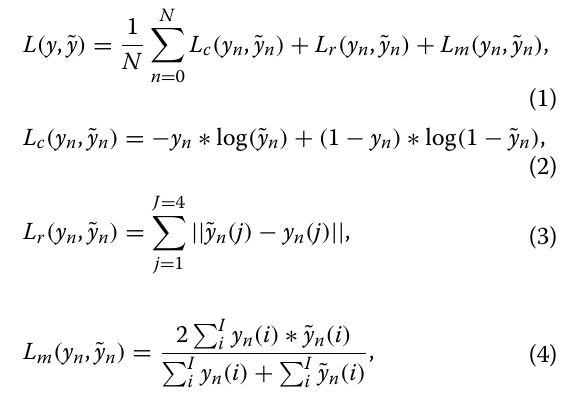
The mask regional convolutional neural network (Mask R-CNN) runs over the convolutional feature vector maps of the ResNet backbone network and produces a segmentation map. The Mask R-CNN works in parallel with the classification and regression network, described in Sect. 4.1. This is also illustrated in Fig. 1. The Mask R-CNN takes a region from convolution feature vector maps with the spatial dimension x × y × z , where x , y and z are in units of width, height and the number of feature maps ( x × y × z is 14 × 14 × 256 and 28 × 28 × 256 ; the window size is determined experimentally). The Mask R-CNN produces a binary map with x × y × 1 . The latter dimension is equal to one because there is only one class (dust storm region or the planetary surface background). foreground pixels, i.e., dust storm pixels, and 0 refers to background pixels, i.e., non-dust-storm pixels.